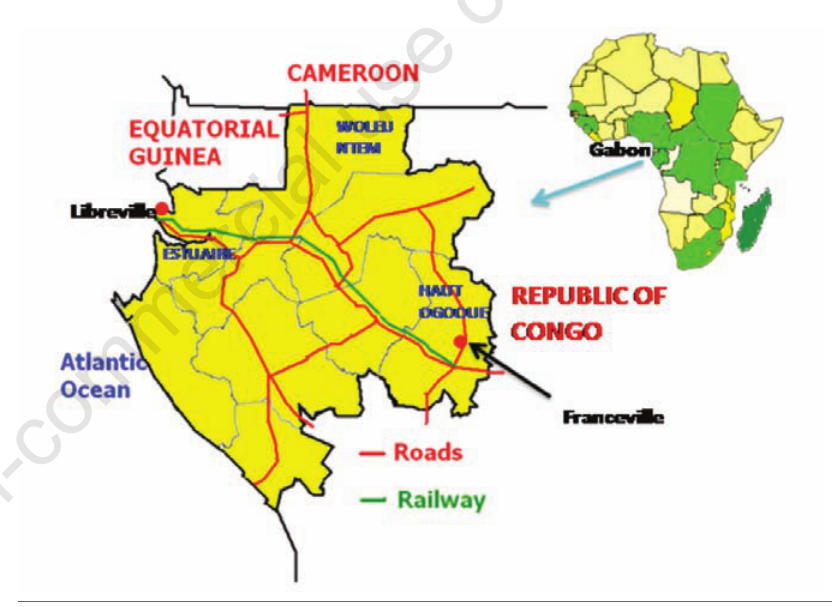
CHIKV+ group (Table 1), and myalgias were more frequent in the CHIKV and DENV groups than in the CHIKV/DENV group (P = 0.005 and 0.02 respectively). Similarly, leukopenia and lymphopenia were more frequent (P respec- tively 0.02 and 0.001) in the DENV+ group than in the CHIKV+ group (Table 2). There